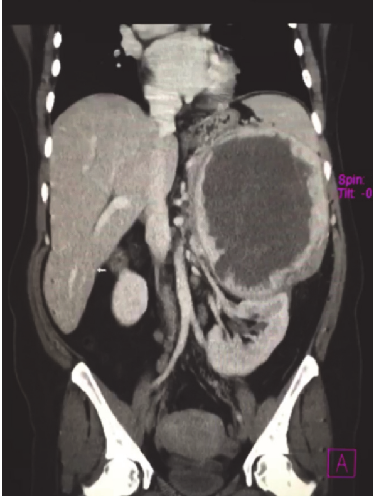
Figure 2: Coronal CT image demonstrating the mass displacing the left kidney inferiorly. Evidence of locally invasive disease was not present.